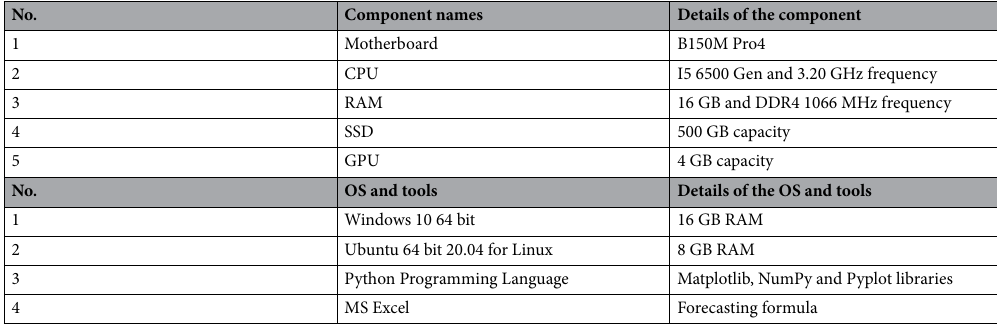
Table 1. Implementation